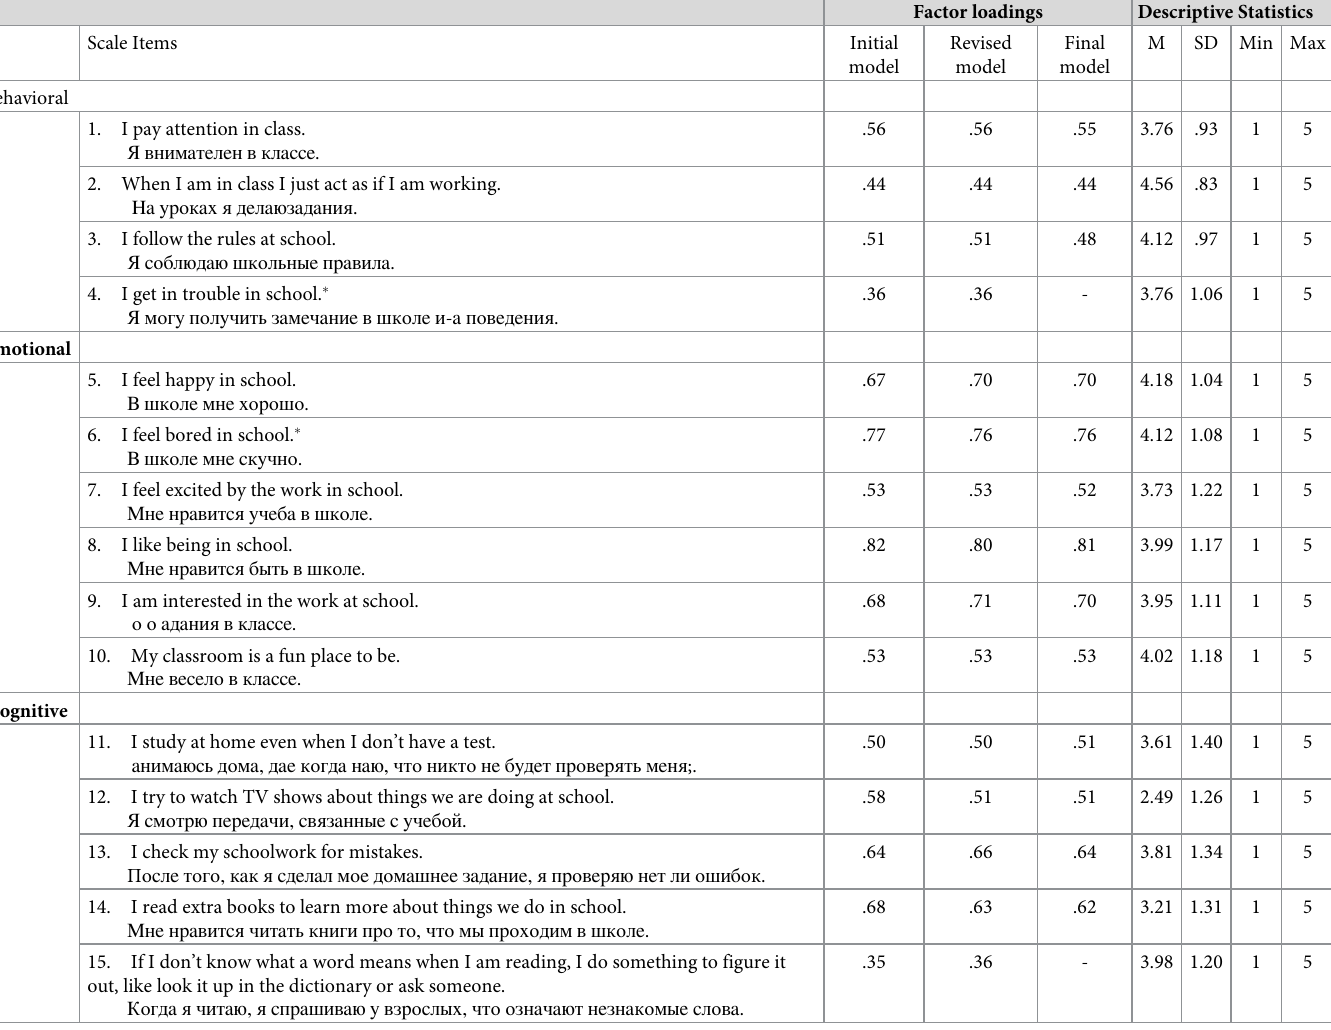
Table 2. Item factor loadings for all three models and descriptive statistics for all items ( n = 537).